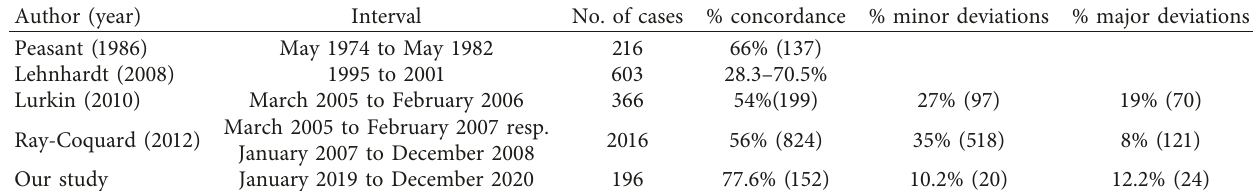
Table 4: Overview of